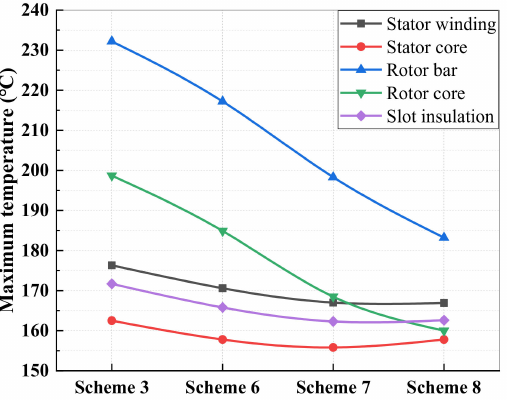
Figure 13. Temperature comparison under the scheme with varying cross-sectional